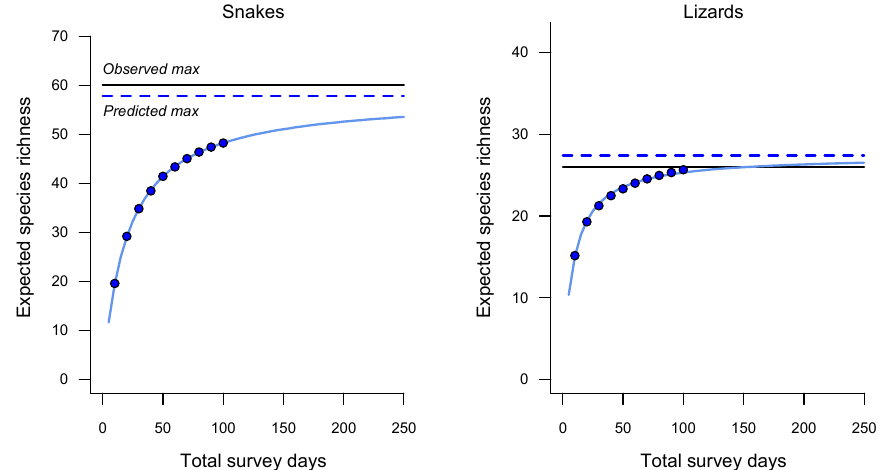
Figure 5. Expected species accumulation curves as a function of survey days for snakes ( left ) and lizards ( right ), using survey data from 2016–2018. Points show mean species richness as a function of survey days obtained from resampling the observed data; underlying blue line corresponds to fitted hyperbolic function [30]. Observed maximum (solid horizontal line) is the total number of species documented from LABS (N = 60), and predicted max (blue dashed line) is the expectation from the resampled survey data.